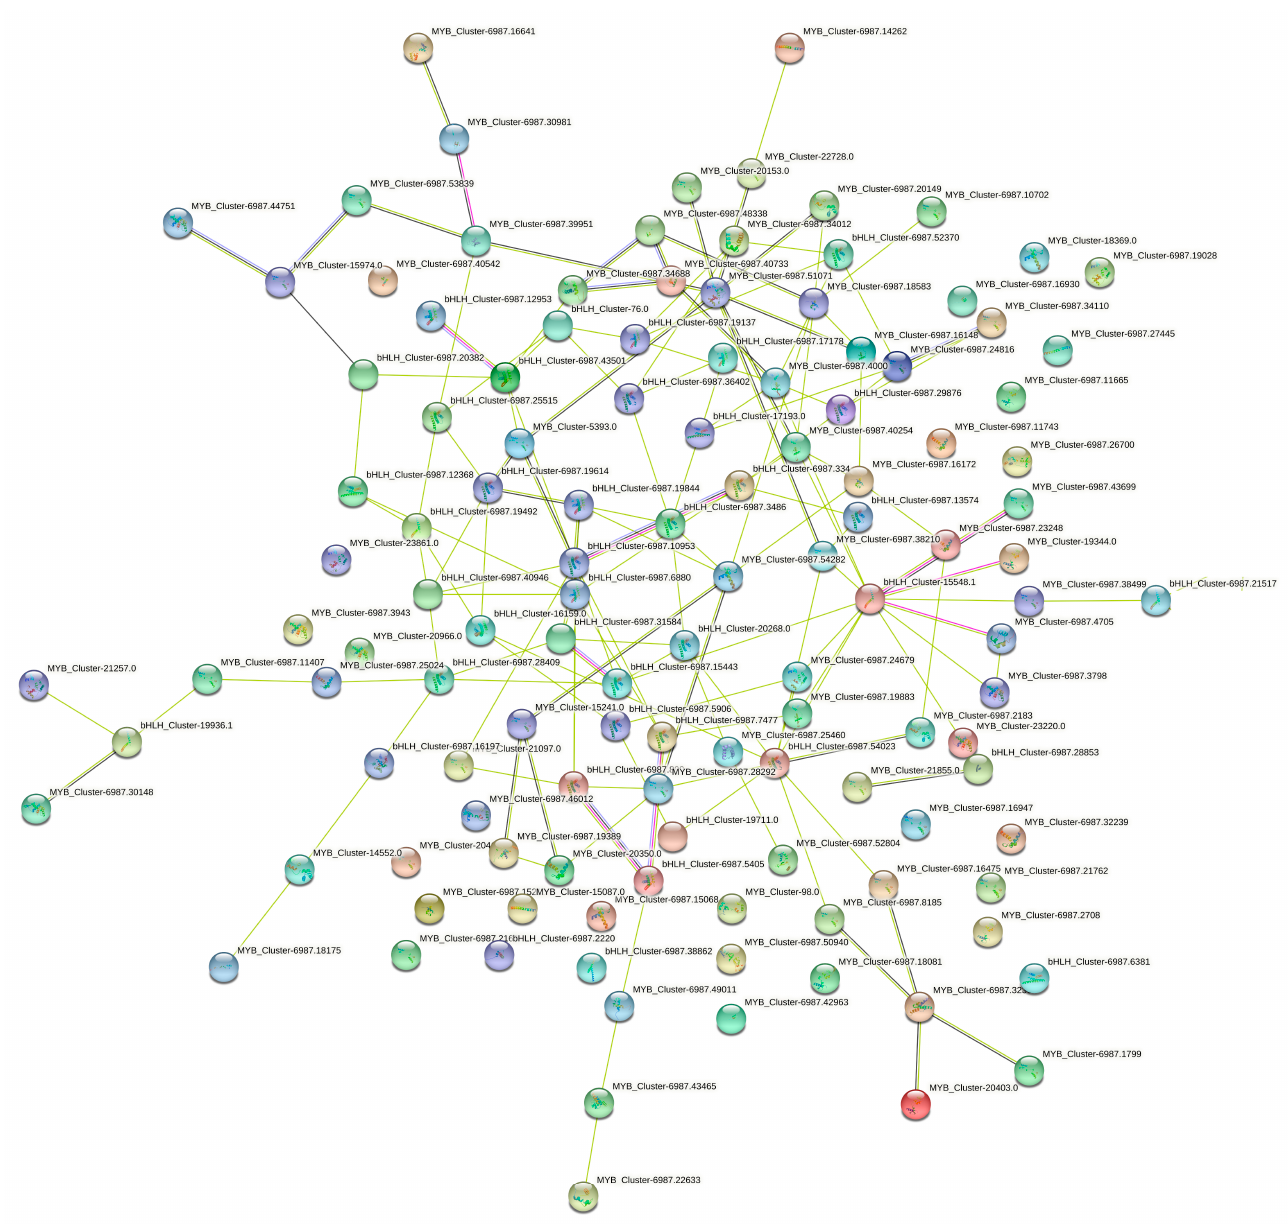
Figure 4. The protein–protein interaction network between bHLH and MYB proteins. Di ff erent coluors have no additional meaning.